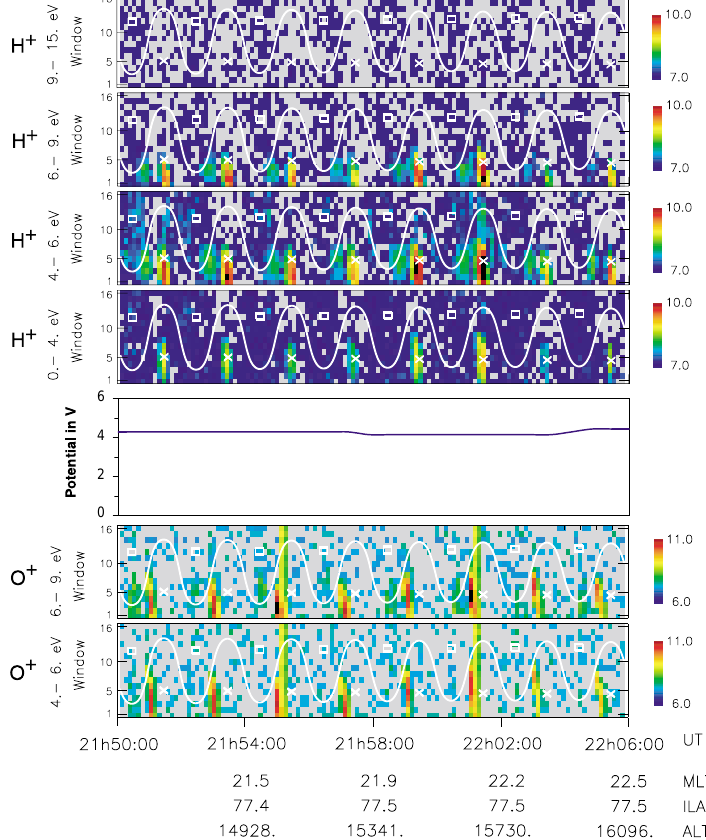
Fig. 7. H + and O + distributions recorded by the Hyperboloid A16 anal- yser on 21 September 1997 between 21:50 and 22:06UT. The upper four panels display the angular variation of h i ( m 2 s sr eV ) − 1 H + fluxes in log for different energy ranges. The middle panel shows the time evolution of the satellite potential, while the bottom two panels display the angular variation of h i ( m 2 s sr eV ) − 1 O + fluxes in log for different energy